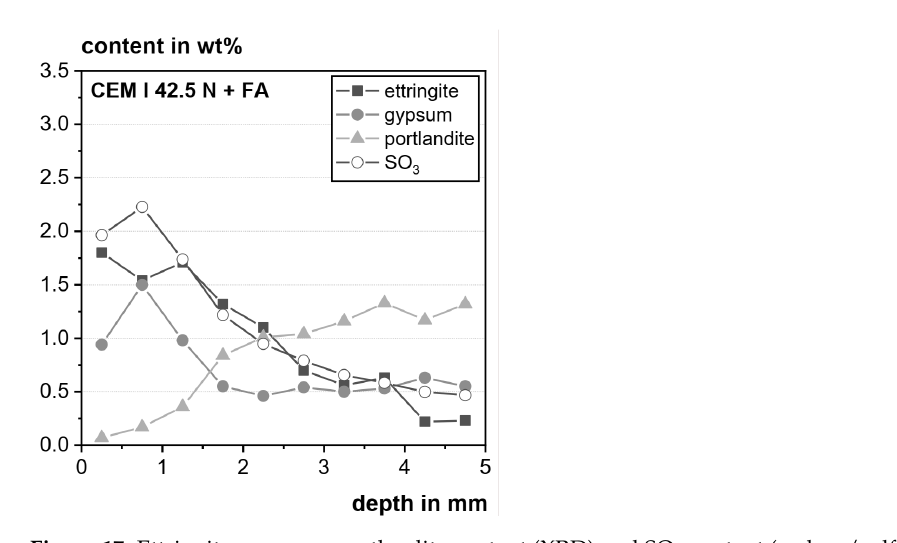
Figure 17. Ettringite, gypsum, portlandite content (XRD) and SO 3 content (carbon/sulfur analysis) over the depth of the specimen with CEM I 42.5 N + FA (w/c = 0.50) stored for 182 d at 5 ◦ C in Na 2 SO 4 solution with 6000 mg SO 42 − /L.